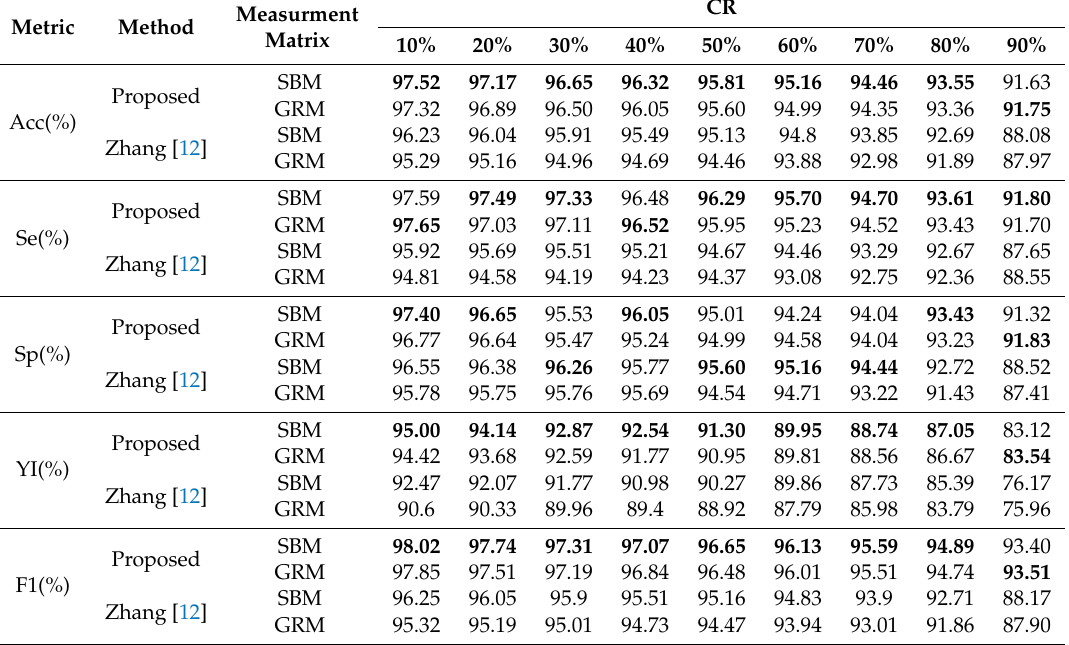
Table 4. Comparison of classification performance of AF detection from compressed ECG using different measurement matrices. This table shows that the classification performance of the proposed method is better than Zhang’s method [12] when using the same measurement matrix. For the same method, there is no significant difference in classification performance using different measurement matrices. Bold numbers represent the best results among the compared